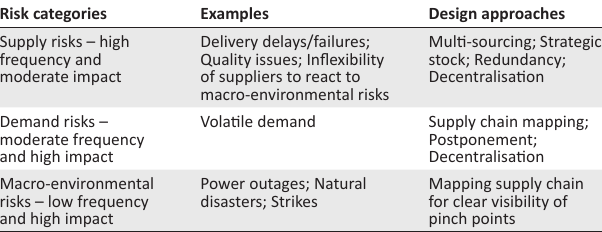
TABLE 3: Link between risks and mitigating supply chain design approaches (a literature